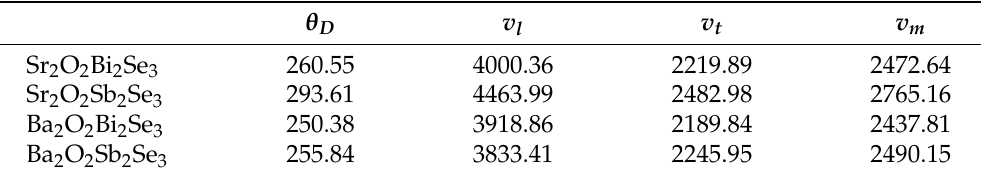
Table 4. Calculated Debye temperature θ D (K), average elastic wave velocities v m (ms − 1 ),